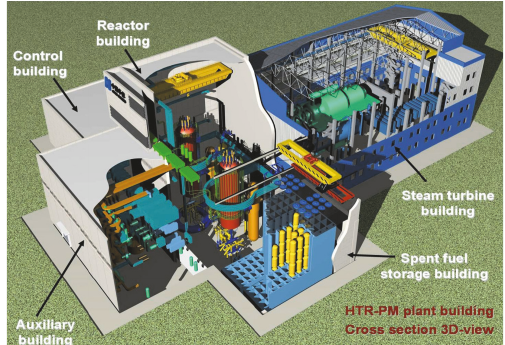
Figure 1: Schematic of HTR-PM600.